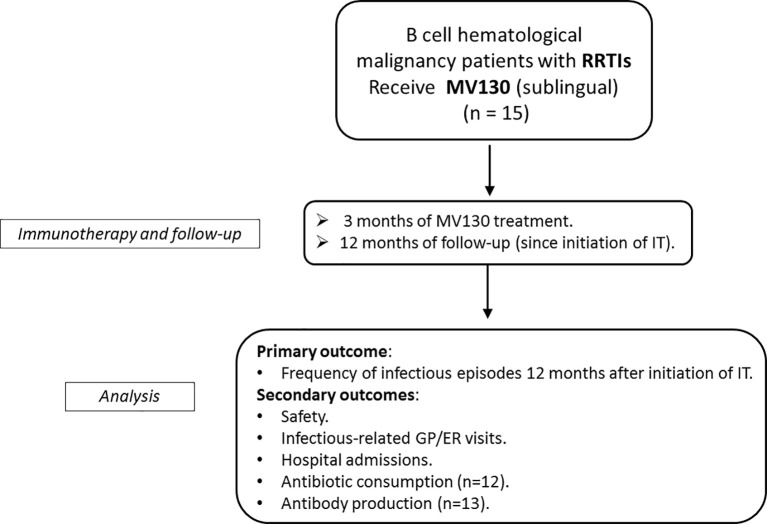
Flow chart of the study including enrolment, medical intervention, therapy and follow-up, and analysis. RRTIs, recurrent respiratory tract infection; IT, immunotherapy; GP, general practitioner; ER, emergency room.